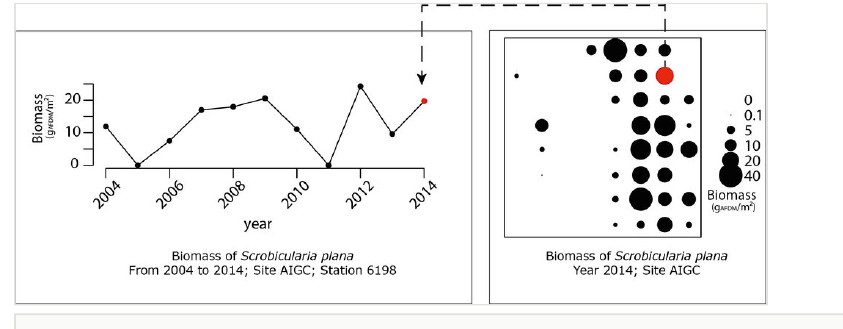
Right side: map of the biomass of Scrobicularia plana on Aiguillon Cove on the Charente- Maritime side (AIC) in 2014; Left side: temporal evolution of one station (n° 1698) of this site for biomass in time since